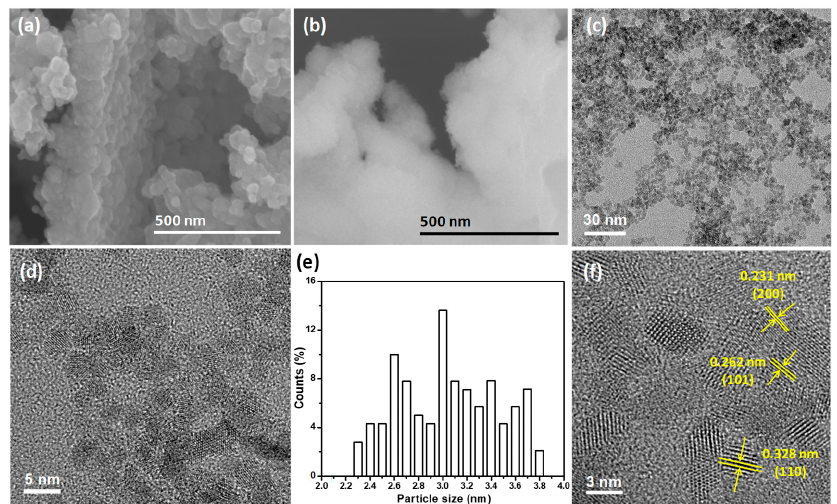
Figure 2. FESEM images of the LS ( a ) and SS ( b ) samples. TEM images ( c , d ), and HRTEM image ( f ) of the SS SnO 2 nanoparticles (NPs). Particle size distribution ( e ) measured from ( c ).